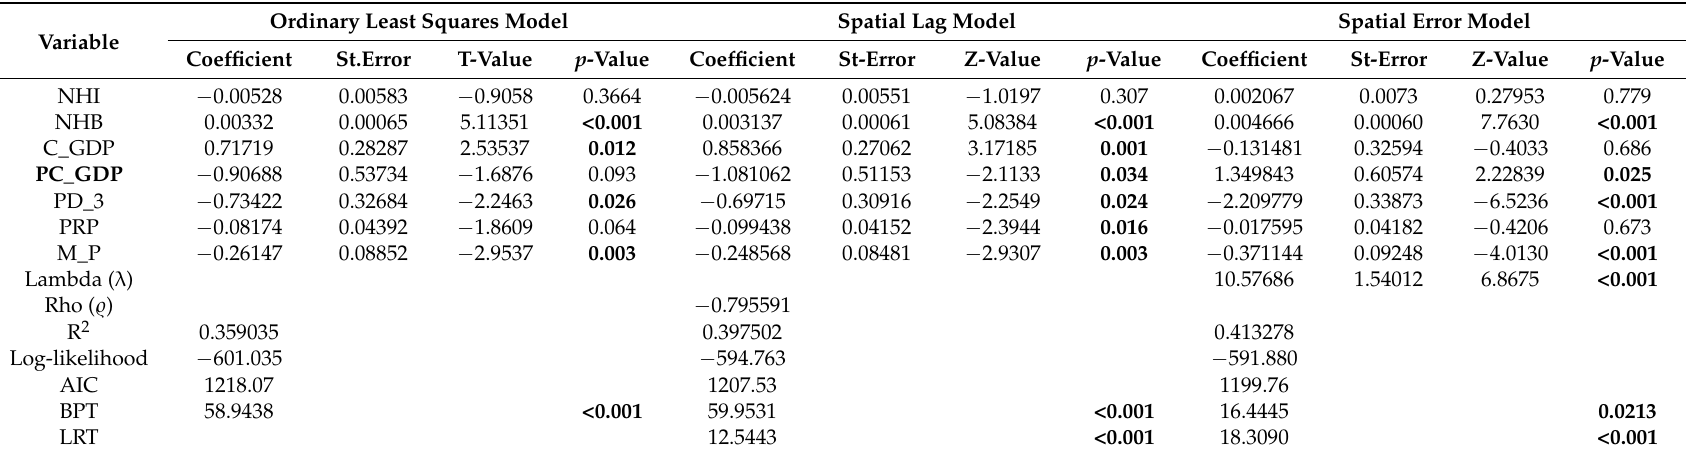
Table 3. Results of the Ordinary least square (OLS) model, the Spatial lag Model (SLM) and the spatial error model (SEM) assessing the correlates of the TB rate with maximum likelihood